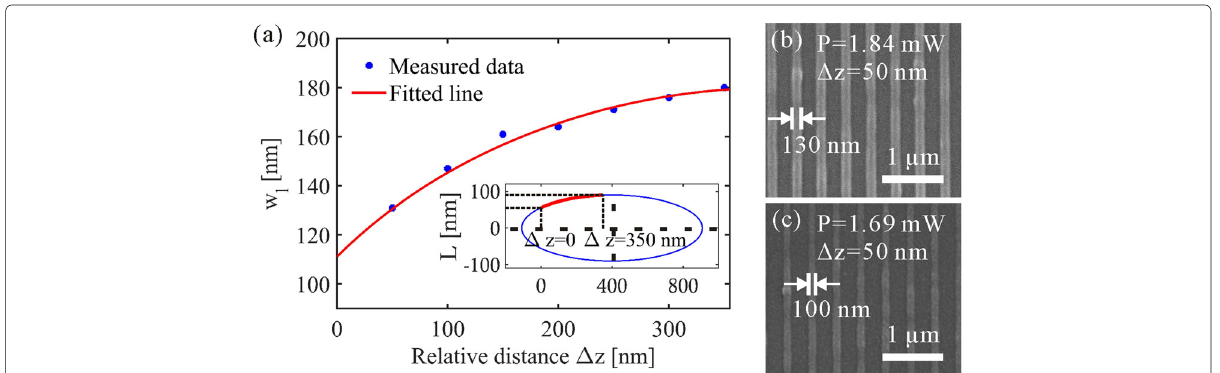
Fig. 7 Grating lines fabricated at the x − y plane with respect to different relative laser focus distance Δ z . Material: E-shell 300. A writing speed of 7 μ m/s was applied. a Measured line width and fitted curve with respect to different Δ z . The figure in the lower right corner is a reconstruction of the ellipse corresponding to the fitted line. b Grating lines fabricated with the laser intensity of I = 0.85kW/ μ m 2 (with the laser power P = 1.84mW). The relative laser focus distance is Δ z = 50nm. c Grating lines fabricated with the laser intensity of I = 0.78kW/ μ m 2 (with the laser power P = 1.69mW). The relative laser focus distance is Δ z =